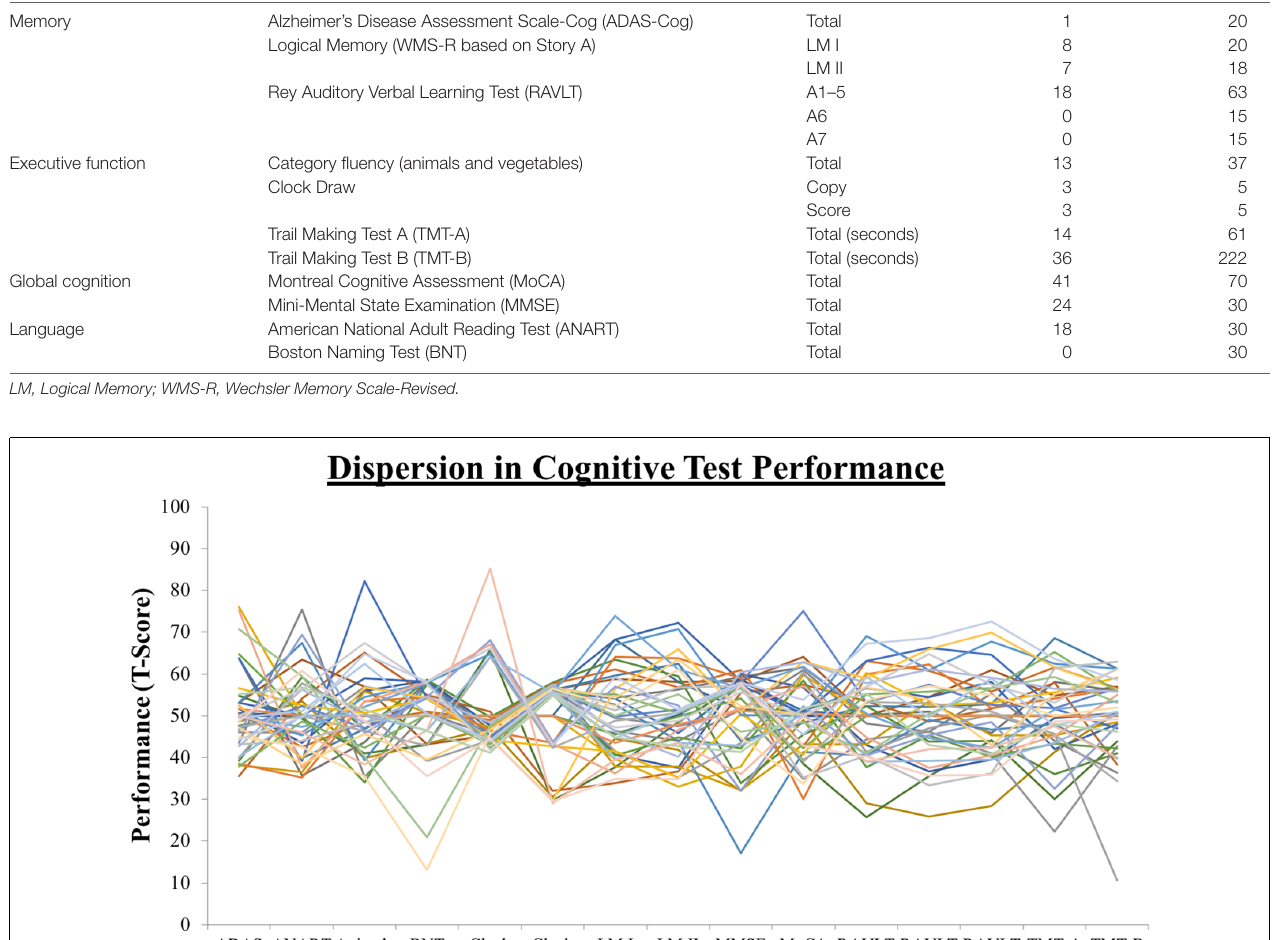
TABLE 1 | List of neuropsychological tests included in the dispersion computations, as well as the lowest and highest scores observed. Cognitive domain